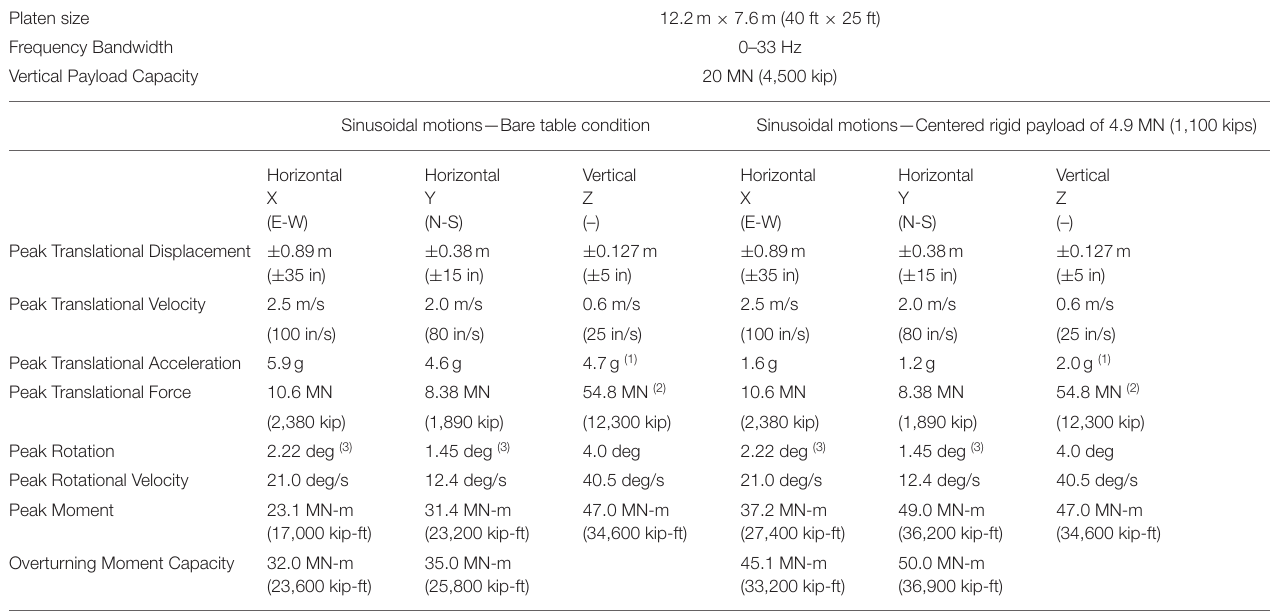
TABLE 4 | Uniaxial performance characteristics of the LHPOST6 Sinusoidal motions—Bare table condition—Centered rigid payload of 4.9 MN (1,100 kips). Platen